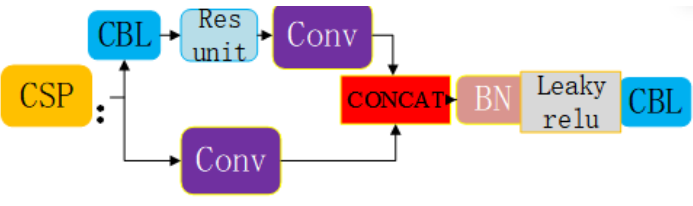
Figure 4. The structure of CSP 1.